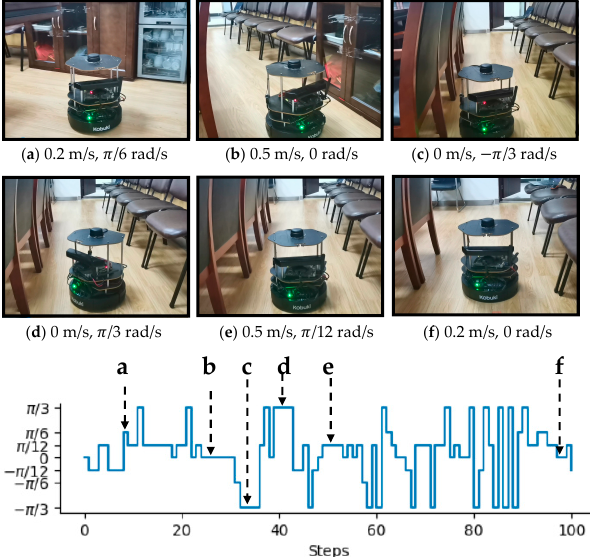
Figure 12. An example of passing through narrow space in a real- world meeting room between two rows of chairs. The subfigures show the third-person view of six intermediate time steps and the sub- captions indicate the corresponding linear and angular velocity commands. Angular velocity commands in all time steps are provided at the